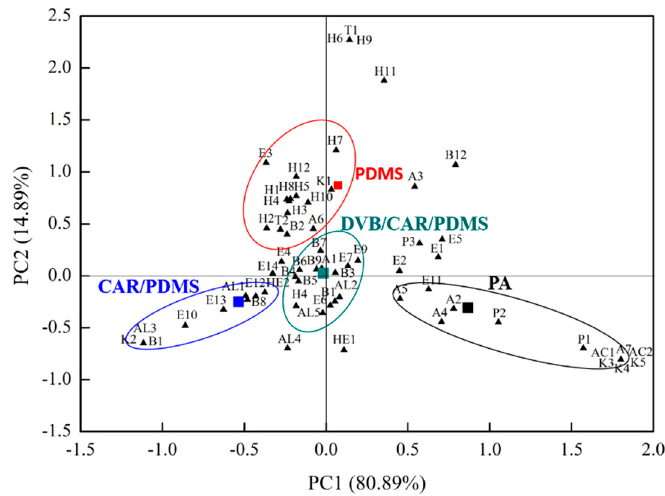
Figure 2 . Principal component analysis (PCA) biplot showing relationship between the four fibers and 64 volatile compounds in proso millet wine.